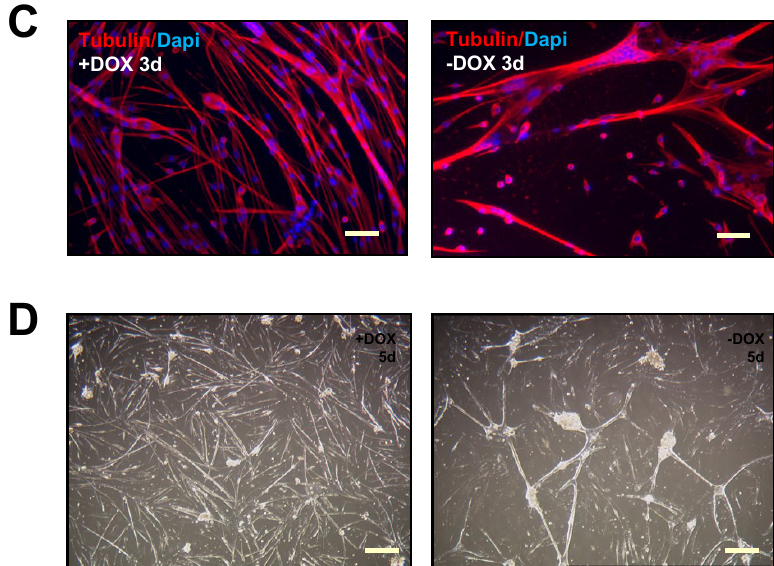
Figure 2. Characterization of proliferating myogenic stem cells (MSCs) and differentiated myotubes from bitransgenic mice. ( A ) Left panels: representative optical images of proliferating MSCs (upper) and differentiated myotubes (bottom) grown for 72 h in uninduced conditions (+DOX); Middle and right panels: representative GFP immunofluorescence (upper) and optical (bottom) images of differentiated myotubes cultured for 24 h (middle) or 72 h (right) in induced conditions (−DOX); ( B ) Tpr–Met protein analysis in western blot of MSCs and myotubes at 24 h or five days of differentiation, cultured in the presence or absence of DOX; ( C ) Immunofluorescence staining of α-tubulin (red) and DAPI (blue) in uninduced (left) and induced (right) myotubes after 72 h incubation in DM; ( D ) Optical images of uninduced (left) and induced myotubes (right) after incubation in DM for five days. Scale bars: ( A , C ) 100 μm; ( D ) 200